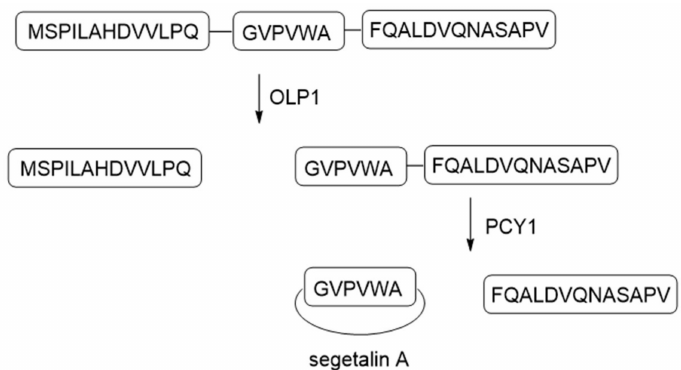
Figure 14. Schematic of segetalin A biosynthetic pathway. Letters in the figure represents single letter notations for amino acids. OLP1 is a serine protease. PCY1 is a peptide cyclase. Adapted from Reference [49].